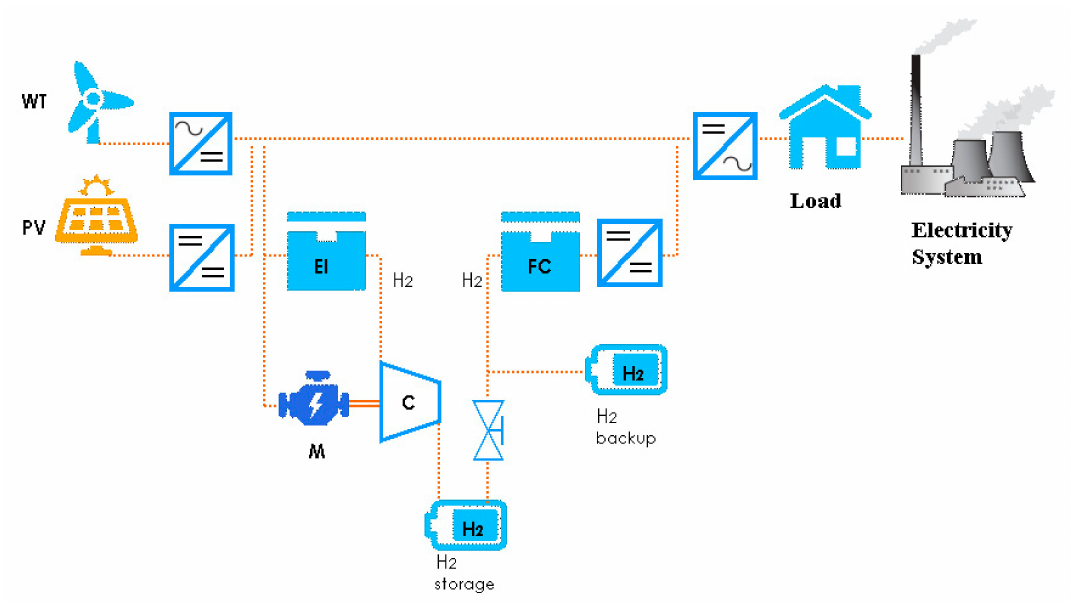
Figure 1. HPGS configuration to optimize the size of the PV / WT / FC hybrid system: PV, WT—renewable (solarandwind)energysources, El—electrolyzer, C—compressor, M—electricmotor,